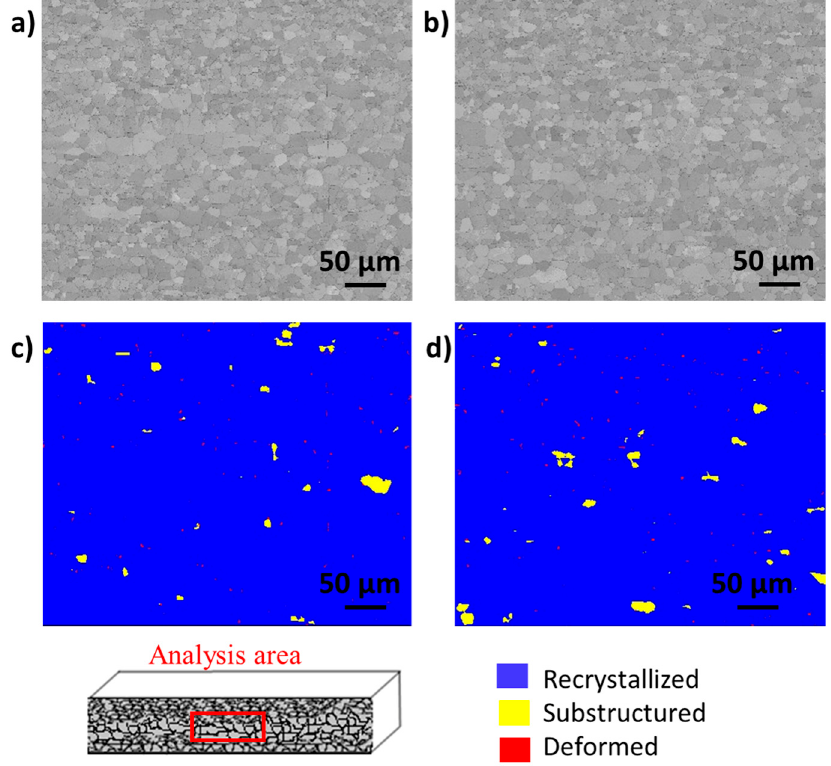
Figure 3. ( a ) Band contrast (BC) map acquired on the FSS1 sample, ( b ) BC map acquired on the FSS2 sample, ( c ) DefRex map acquired on the FSS1 sample, ( d ) DefRex map acquired on the FSS2 sample.